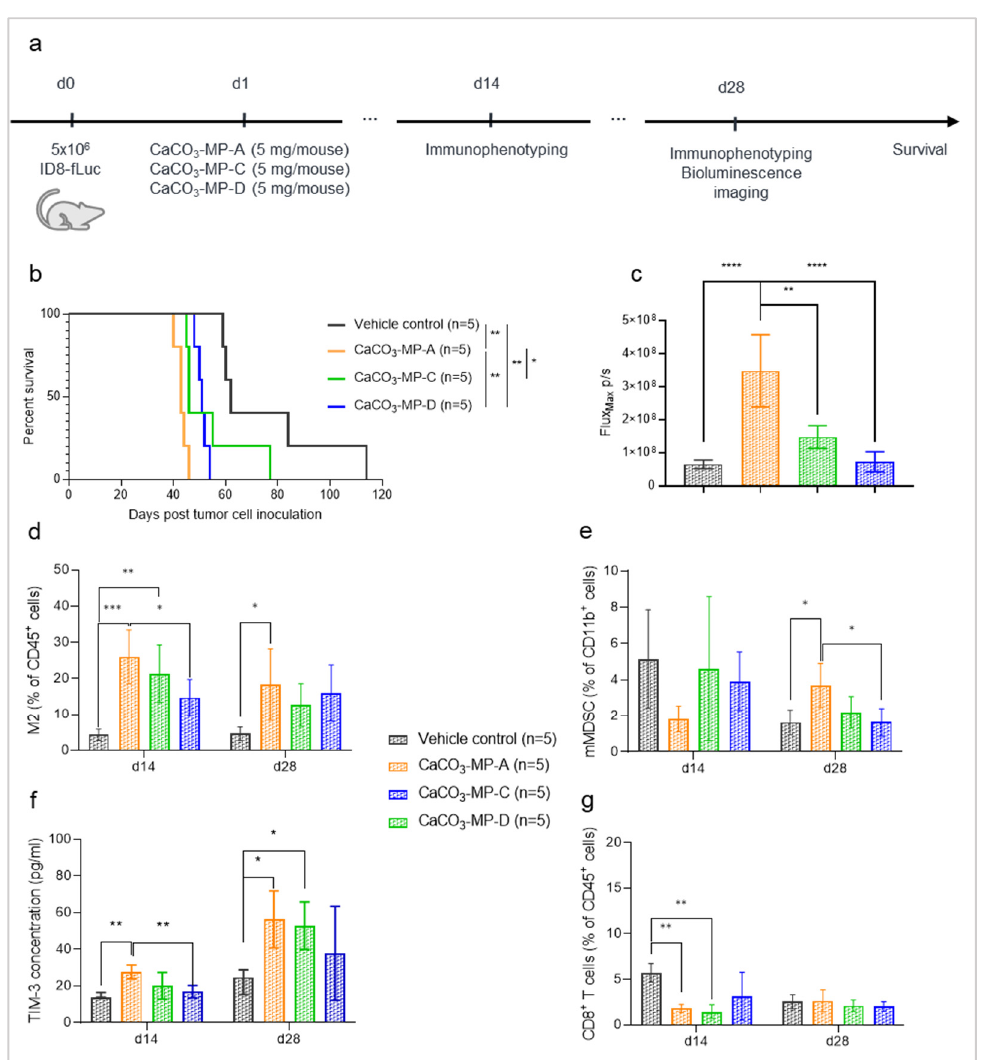
Figure 4. Experimental set-up of the experiment ( a ) with corresponding Kaplan–Meier survival curve ( b ), bioluminescence imaging quantification ( c ) and immune profile of the tumor microenvironment on day 14 and 28 post tumor cell inoculation ( d – g ) of mice injected with vehicle control, 5 mg of CaCO 3 -MP-C, 5 mg of CaCO 3 -MP-D or 5 mg of CaCO 3 -MP-A. ( b , c ): Different degrees of accelerated tumor progression were observed for all CaCO 3 product formulations. ( d – f ): In general, a different degree of immune suppression in the tumor microenvironment is observed in response to CaCO 3 -MP-C, CaCO 3 -MP-D and CaCO 3 -MP-A, as reflected by the increase in M2 macrophages, mMDSC and the immune checkpoint TIM-3. ( g ): The CD8 + T cells were suppressed by all three product formulations of CaCO 3 . MDSC: myeloid-derived suppressor cell, TIM-3: T cell immunoglobulin and mucin domain-containing protein 3. Degree of significance: p adj <0.05 (*), p adj < 0.01 (**), p adj < 0.001 (***), p adj < 0.0001 (****).